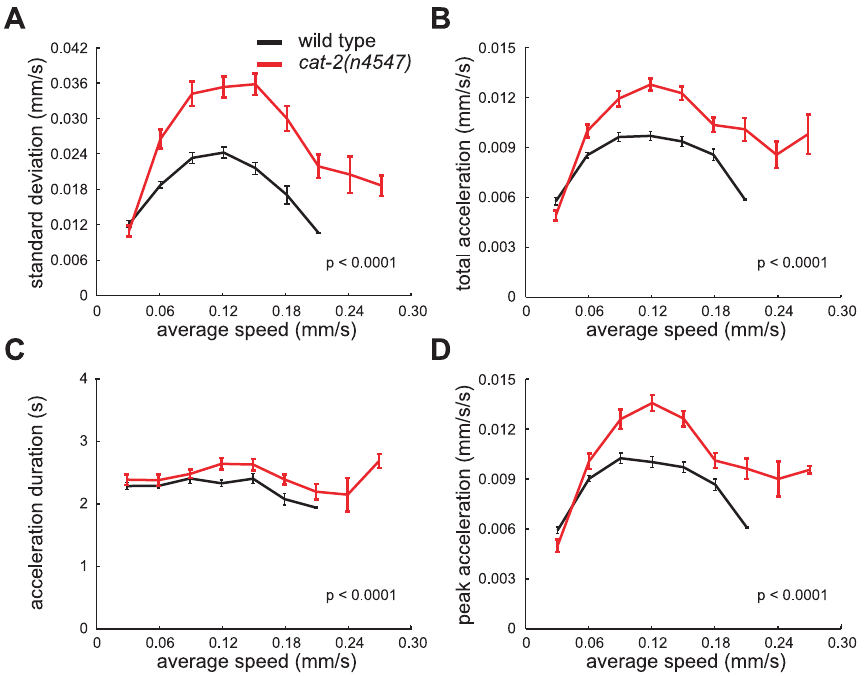
Figure 4. cat-2 mutants achieve greater peak acceleration, resulting in large fluctuations in the speed within tracks. The average (A) standard deviations of speed measurements within individual tracks, (B) magnitude (root mean square) of accelerations, (C) duration of accelerations, and (D) acceleration peaks for animals on a bacterial lawn. p-values for differences between data curves for each genotype were calculated using two-way ANOVA. Tracks were first grouped by average speed. Each bin is 0.03 mm/sec wide. Error bars, SEMs. (wild-type n=358 tracks; cat-2(n4547) n=262 tracks, all tracks . 30 sec)